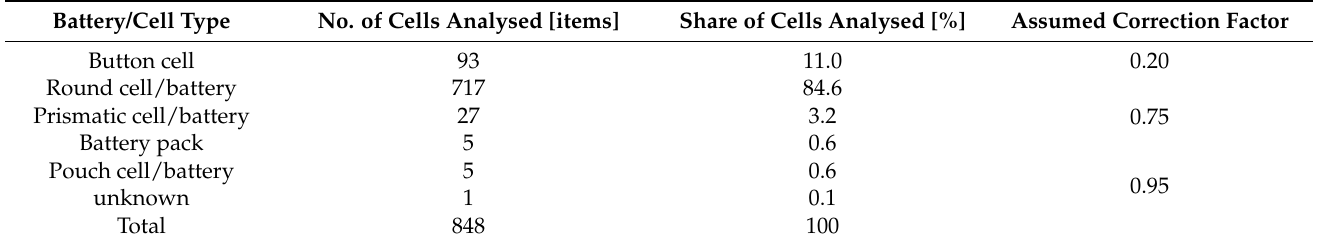
Table 7. Shape/construction type of the analysed portable